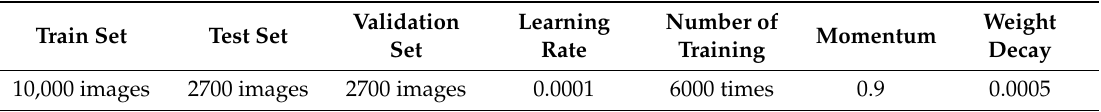
Table 2. Training related